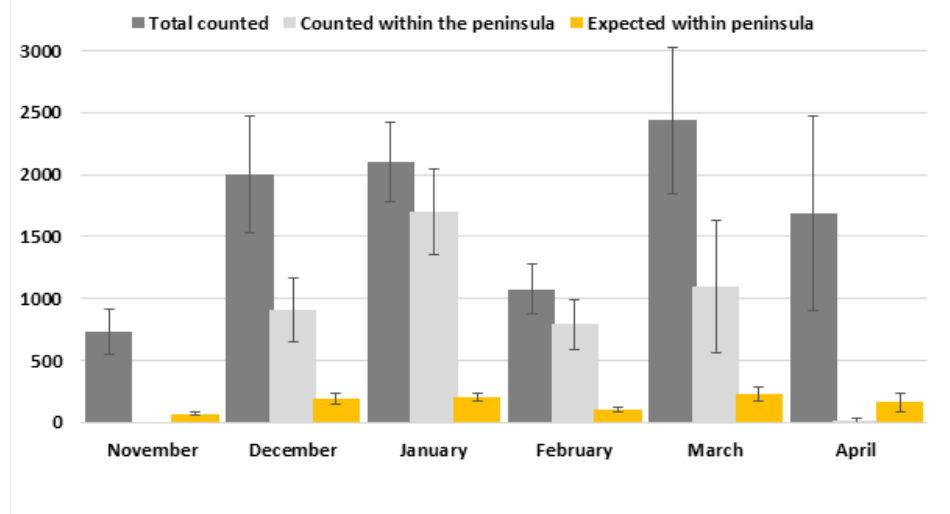
Figure 5. Mean monthly number ± SE of wild reindeer observed vs expected during ground surveys in